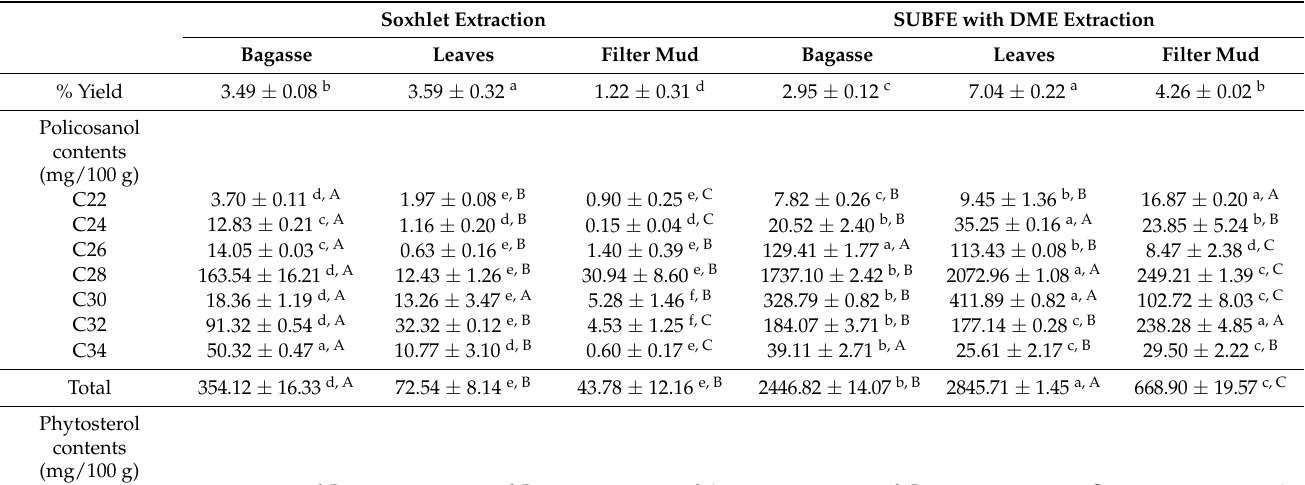
Table 3. Policosanol and phytosterol contents of by-products using SUBFE with DME and Soxhlet extraction with a